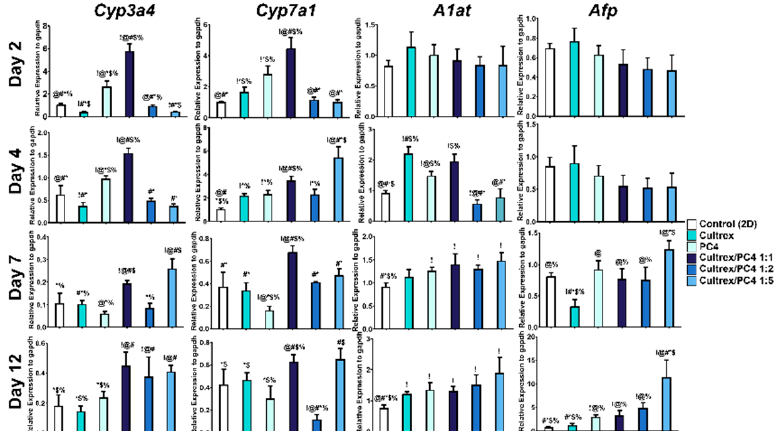
Figure 6. Gene expression of hepatic functional markers ( Cyp3a4, Cyp7a1, A1at , and Afp ). After HepG2 cells were cultured in different conditions from day 2 to 12, the mRNA expression profile was determined by qPCR. ! indicates groups compared with control (2D). @ indicates groups compared with Cultrex. # indicates groups compared with PC4. * indicates groups compared with Cultrex/PC4 1:1. $ indicates groups compared with Cultrex/PC4 1:2. % indicates groups compared with Cultrex/PC4 1:5. The results from the three independent experiments are presented as the mean ± standard deviation. !, @, #, *, $, % p < 0.05.